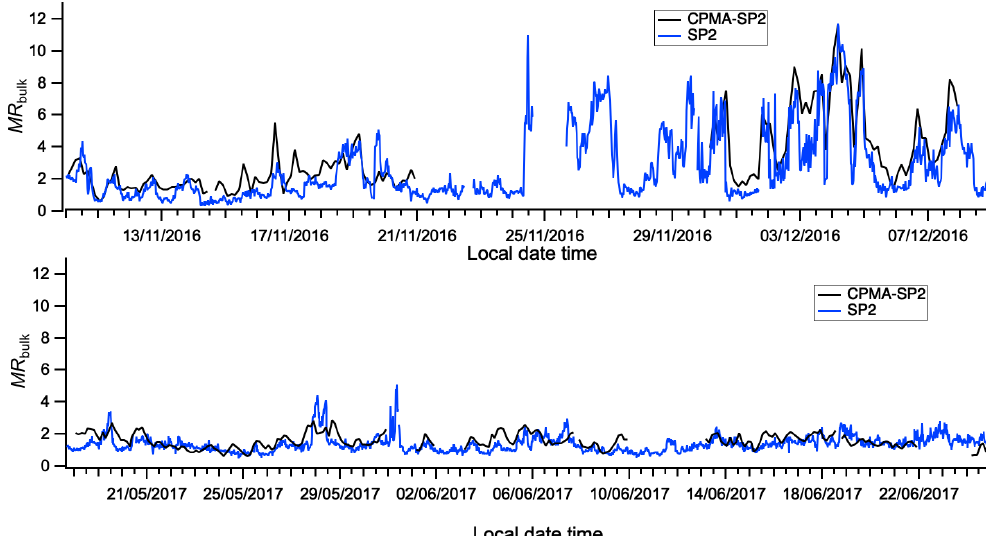
Figure 7. Time series of MR bulk for winter and summer.